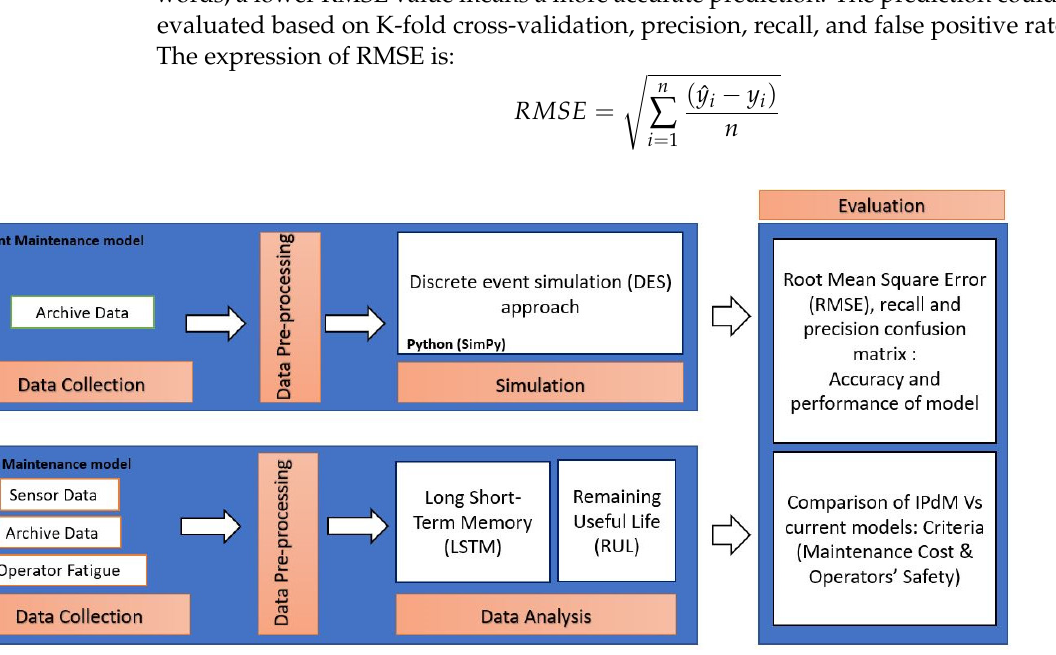
Figure 8. Different step to develop and evaluate the IPdM model in forestry.